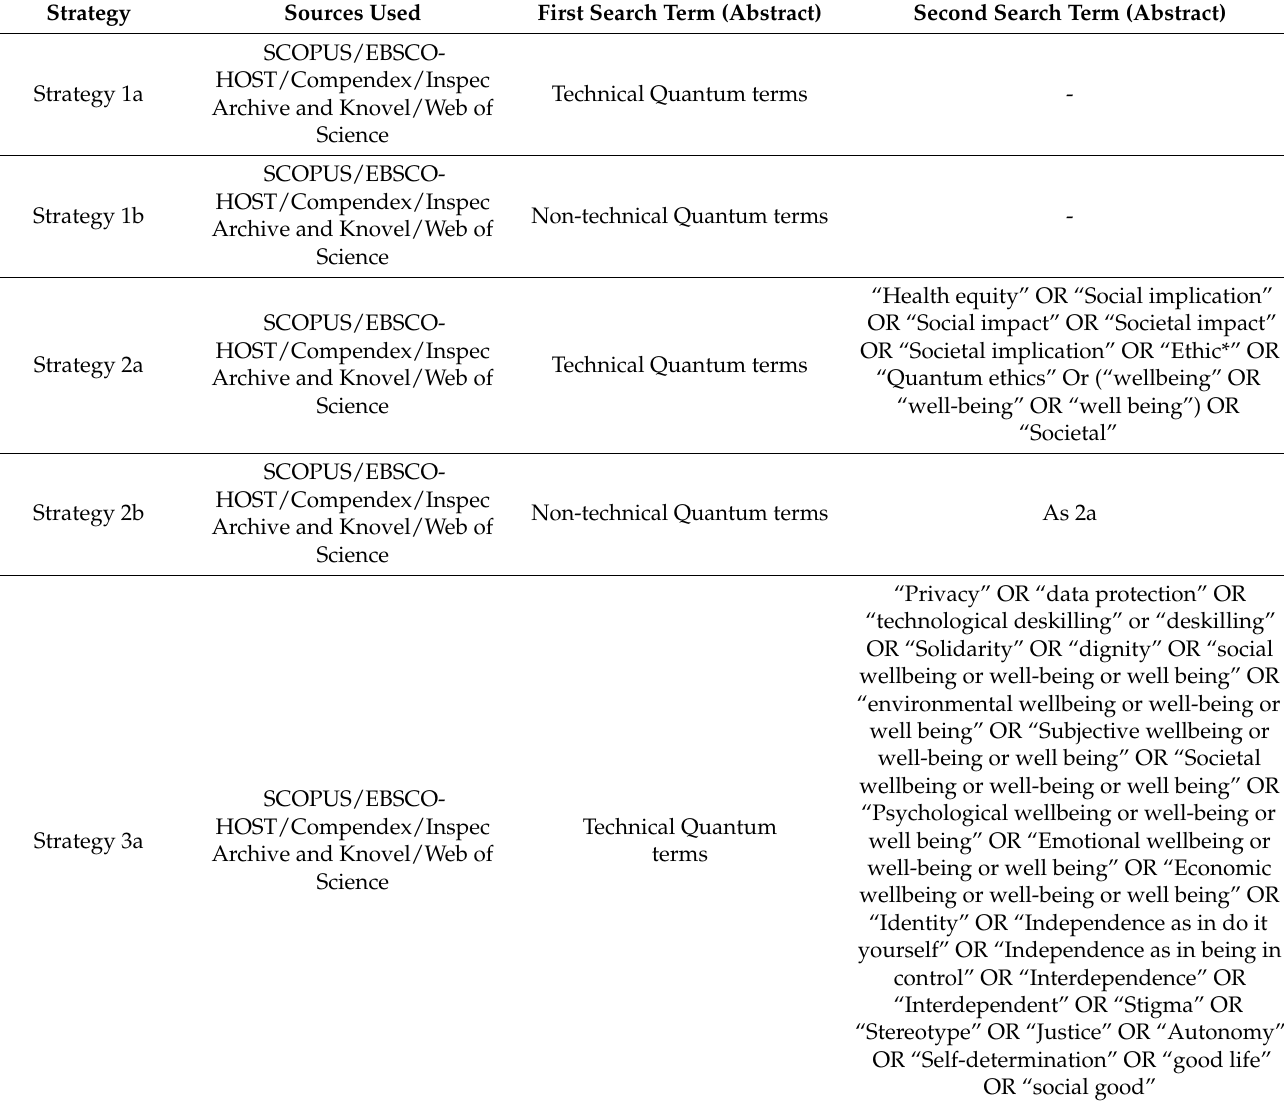
Table 1. Search strategies used to obtain abstracts (first search term) for manifest coding of terms related to the ‘social’ (second search